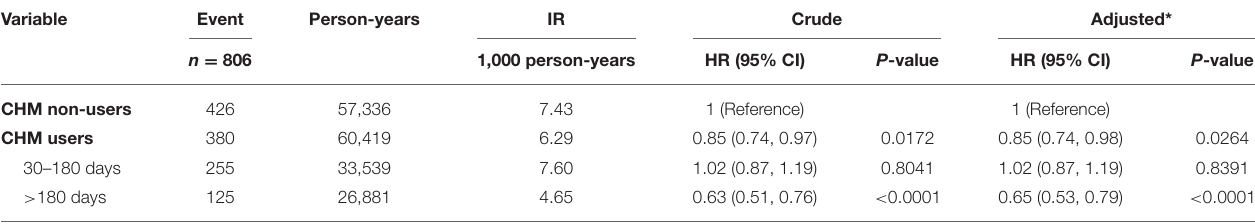
TABLE 2 | IRs and crude and adjusted HRs with 95% CIs of heart failure between hypertensive patients with and without CHM treatment. Variable Event Person-years